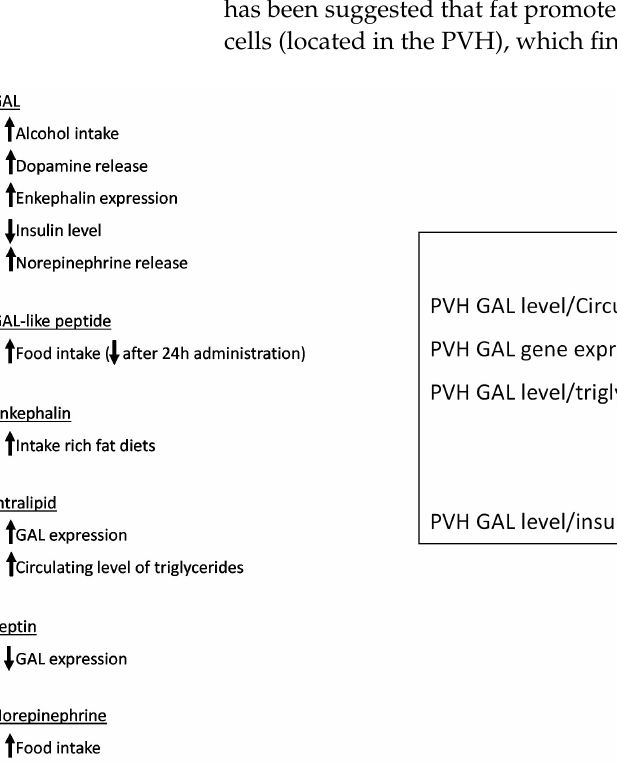
Figure 3. Paraventricular hypothalamic nucleus: physiological effects promoted by different substances when they were administered into the nucleus (left side). Some positive/inverse relationships are also shown (right side). ↑ : increase; ↓ : decrease. GAL: galanin; PVH: paraventricular hypothalamic